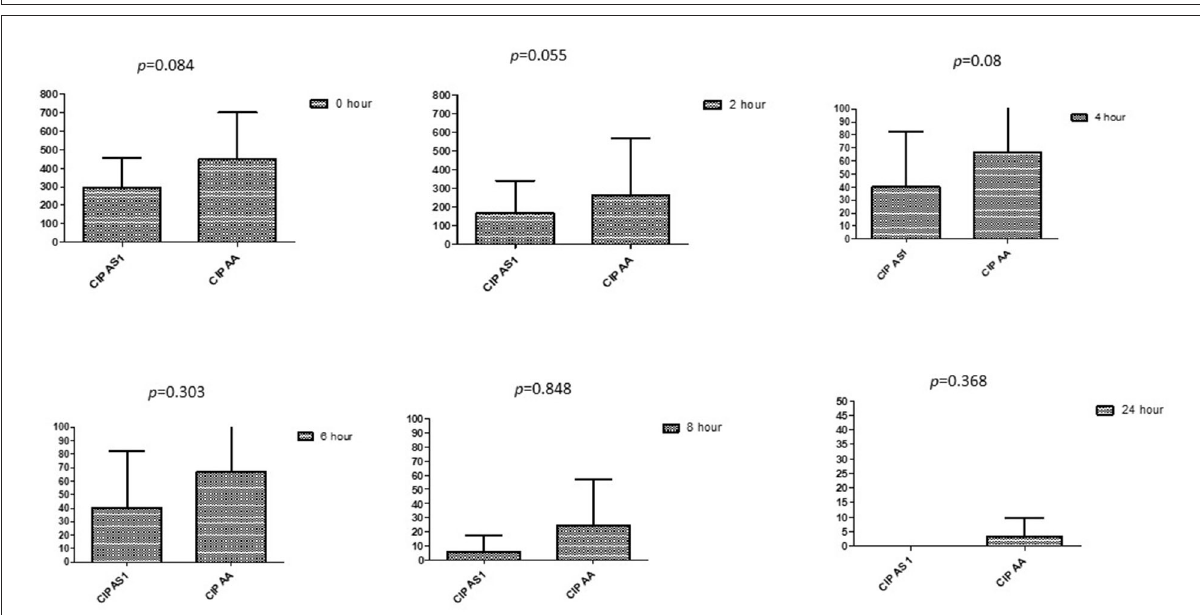
FIGURE6 Comparison of ciprofloxacin’s minimum inhibitory concentrations ( µ g/mL) when combined with AA and AS on E. coli. CIP AS, Ciprofloxacin combined with AS; CIP AA, Ciprofloxacin combined with AA; p < 0.05 indicate a significant difference among MICs of antibiotic combined AS1 and